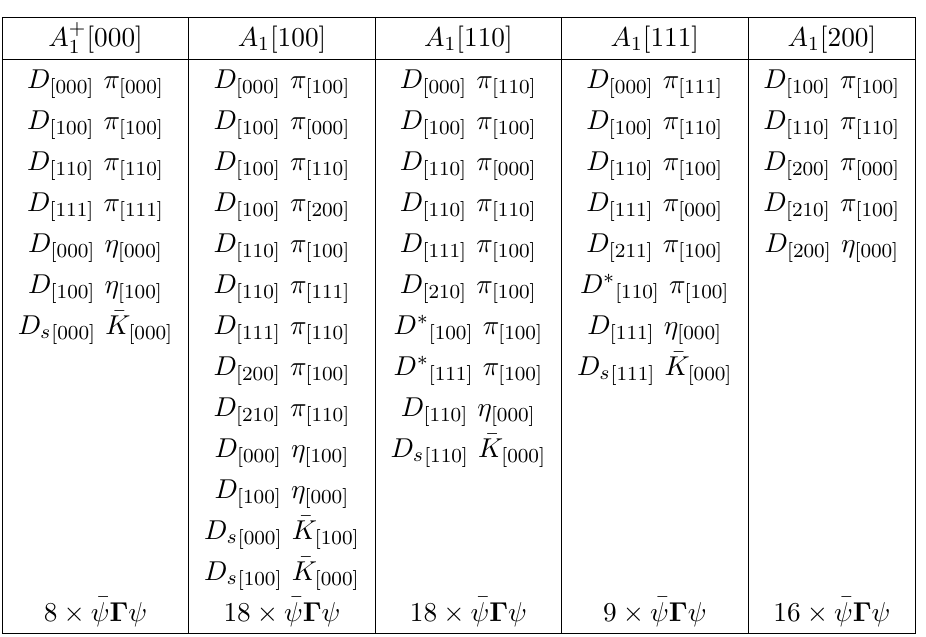
Table 6. Operators used in the variational analyses for irreps featuring S -wave Dπ as the lowest subduced partial wave. Subscripts indicate momentum types. Γ represents some monomial of γ matrices and derivatives.